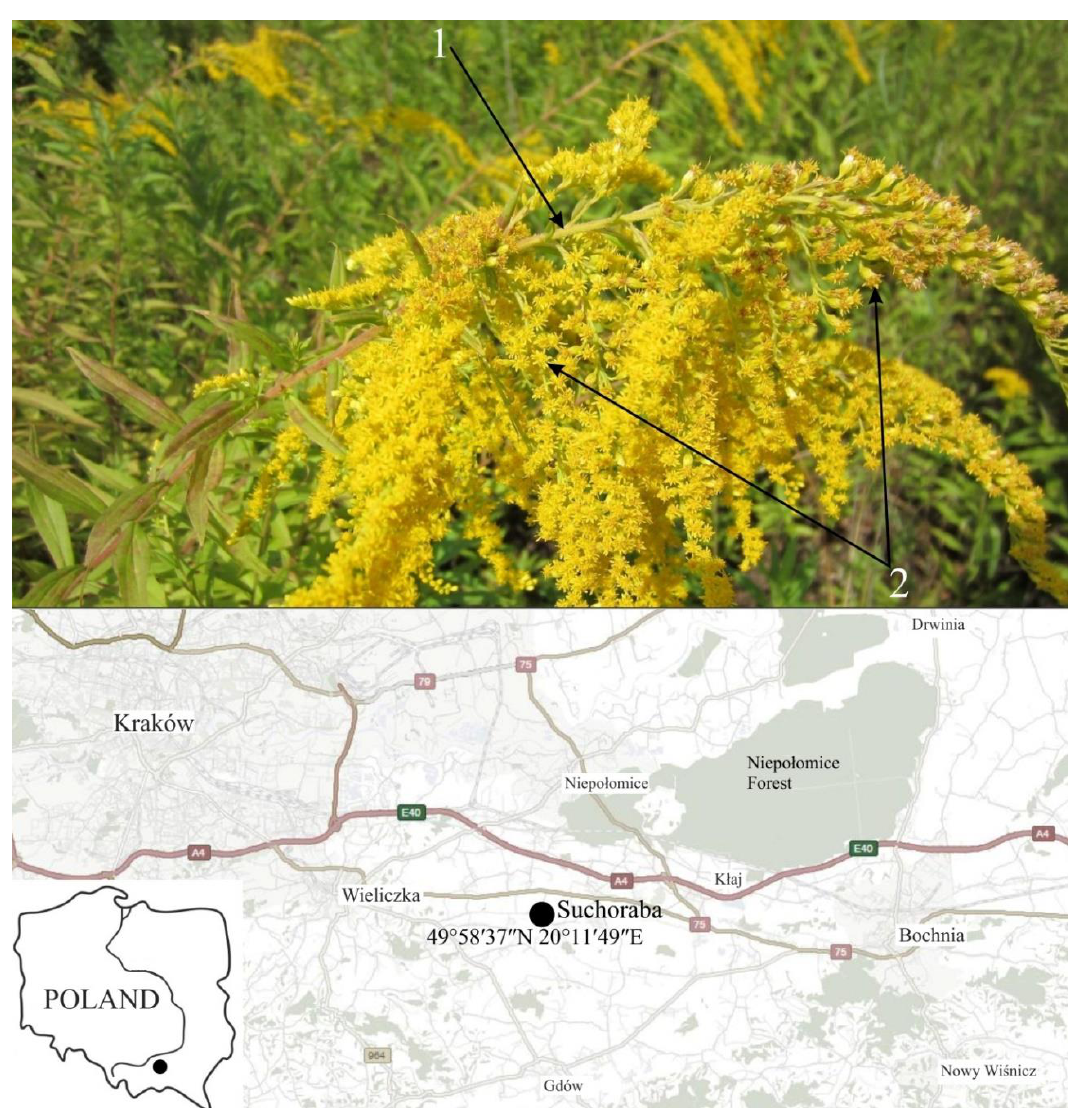
Figure 1. General appearance of Solidago canadensis L.–arrows indicate diagnostic features: ( 1 ) hairy stem and ( 2 ) all the “lingule” flowers of equal length in composite inflorescences (Photo. J. Puła); place of collecting the plant material for experiment.